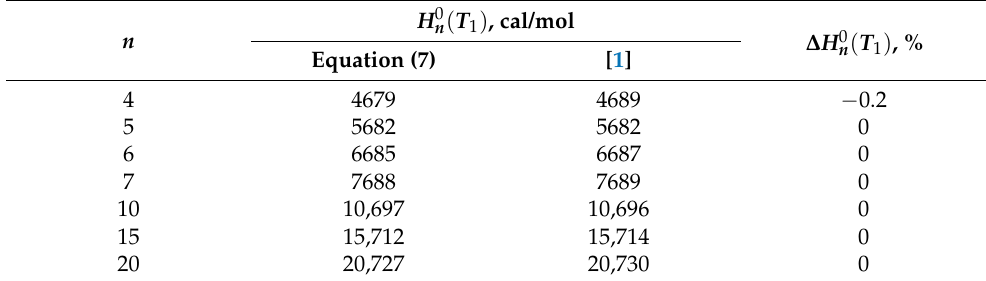
( T ) at temperatures other than T To apply Equation (6) for calculating H 0 1 = 300 K, n ( T ) in Equation (5). For this purpose, let us approximate one has to take integral of C 0 P , n ( T ) , and n -hexane, C 0 ( T ) , the tabulated data [1] for the specific heats of n -pentane, C 0 P ,5 P ,6 entering Equations (5) and (4) by the third-order polynomials in temperature in the range of 298.16–1500 K: